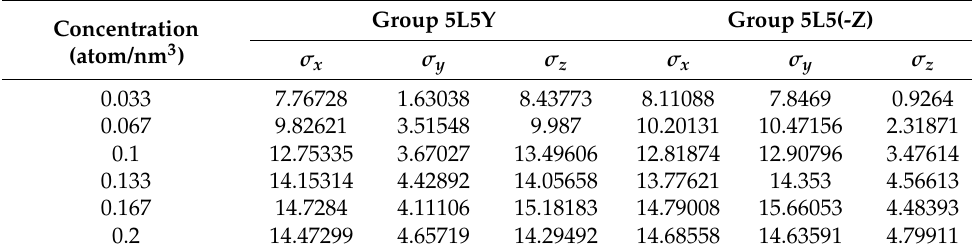
Table 4. The variance of the stress components at the velocity is 40 ˚A/ps.